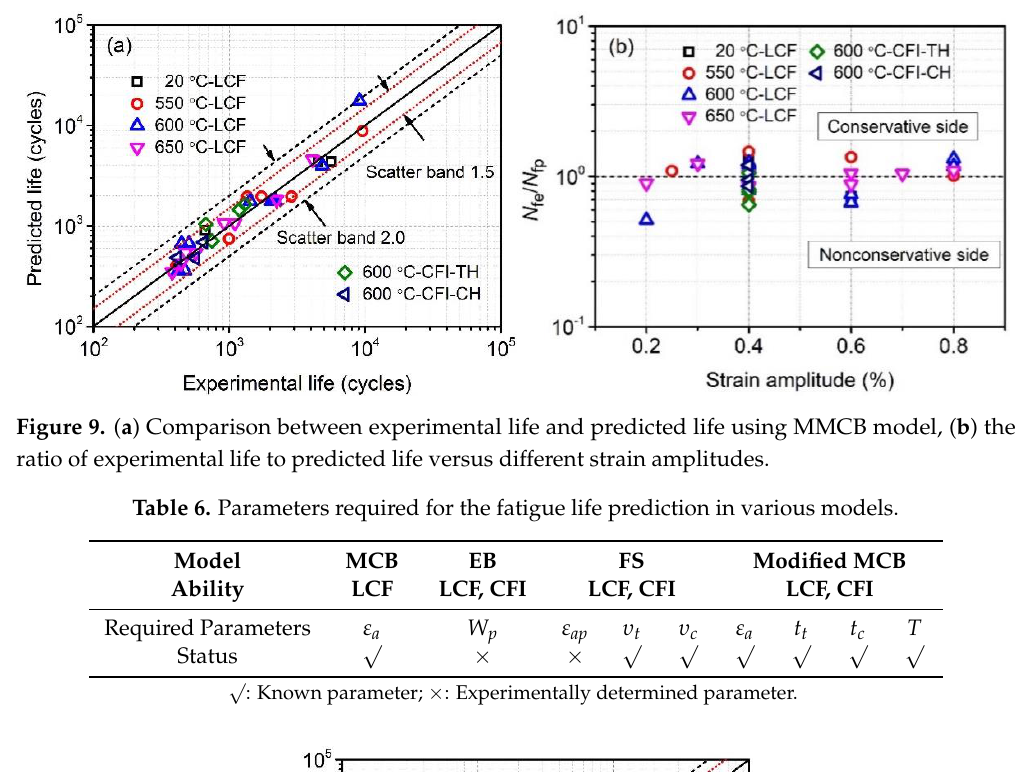
Figure 10. Comparison between experimental life from [47] and predicted life using MMCB model. Table 6. Parameters required for the fatigue life prediction in various models.